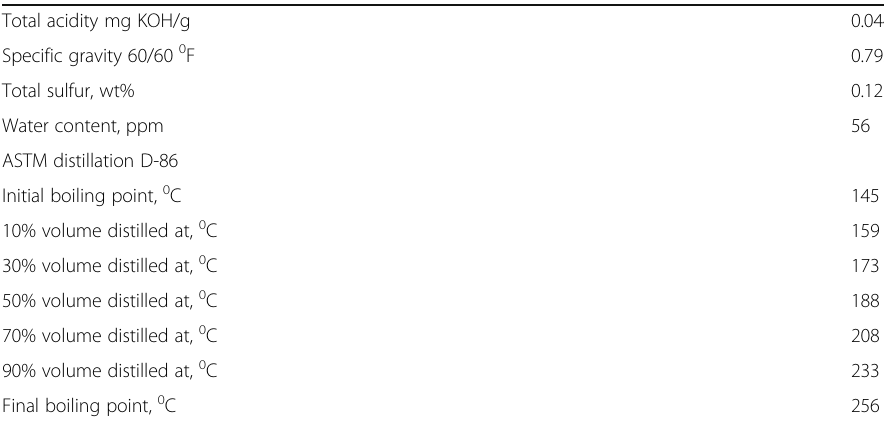
Table 2 Properties of kerosene